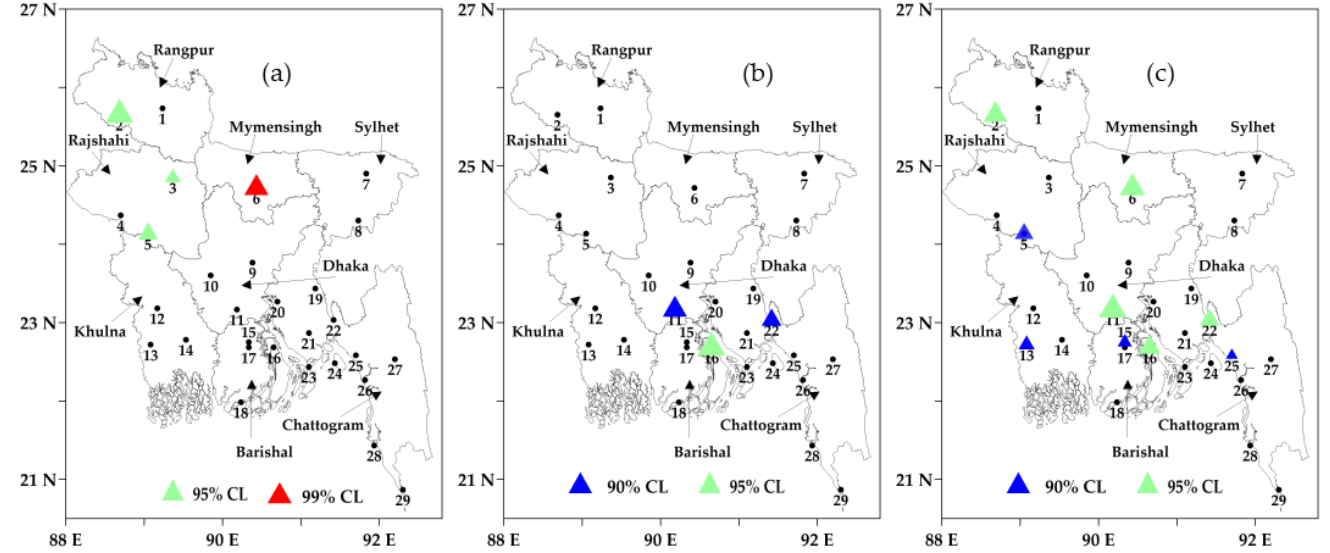
Figure 8. Significant decadal trends of the cold days during ( a ) 10–20 December, ( b ) 21–31 December, and ( c ) month of December as a whole across the country during 2000–01 to 2020–21, where CL means confidence level and the size of the triangle represents the magnitude of the decadal trend values. The black numbers are the IDs of meteorological stations.